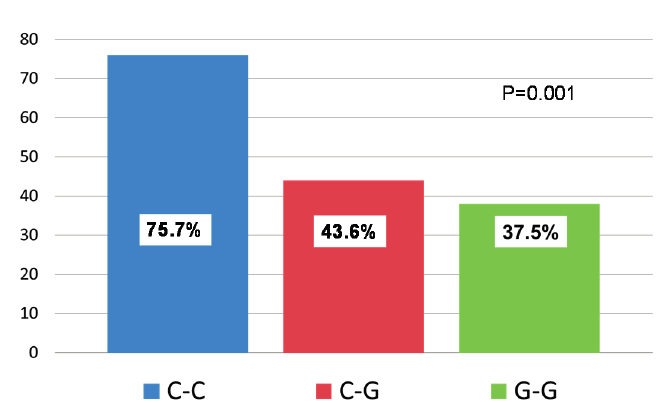
Figure 1. Prevalence of coronary calcium by genotype. The p -value was obtained using the Fisher’s exact